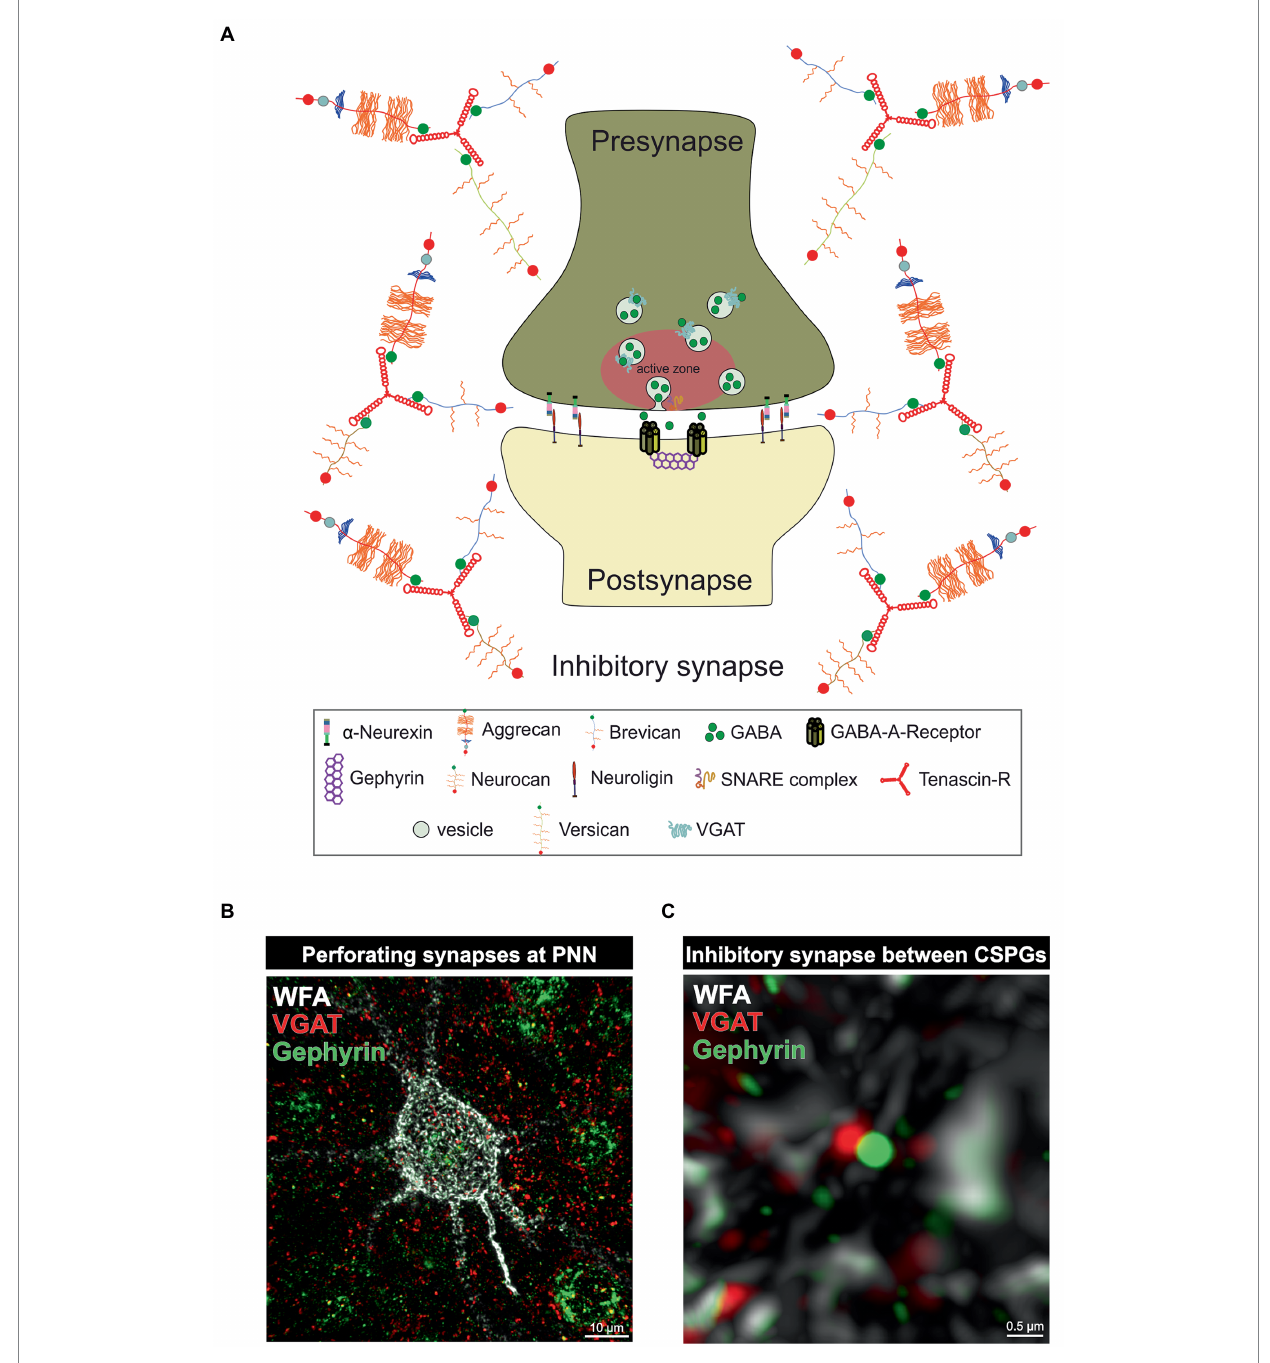
FIGURE 2 PNNs as organizer of inhibitory synapses. (A) Scheme of an inhibitory GABAergic synapse surrounded by a PNN. PNNs surround pre- and postsynapse and stabilize the neuronal connection. Afferent axons can perforate the PNN “wholes” and build synaptic boutons with postsynapses at the cell surface. Components of the PNNs can reach the perisynaptic space and limit synaptic receptor mobility. They also act as buffer and can supply the synapse with cations important for synaptic function. (B) Image of an immunohistochemical staining of a PNN and perforating inhibitory synapses recorded by structured illumination microscopy. PNNs were visualized by lectin labeling of the CS-GAGs via WFA (white), inhibitory presynaptic puncta via an antibody against VGAT (red) and inhibitory postsynaptic puncta via an antibody against gephyrin (green). (C) Pre- and postsynaptic inhibitory elements use the space between the PNN components of the PNNs to form inhibitory synapses there, as shown at the higher magnification. The close proximity to the PNNs ensures synaptic